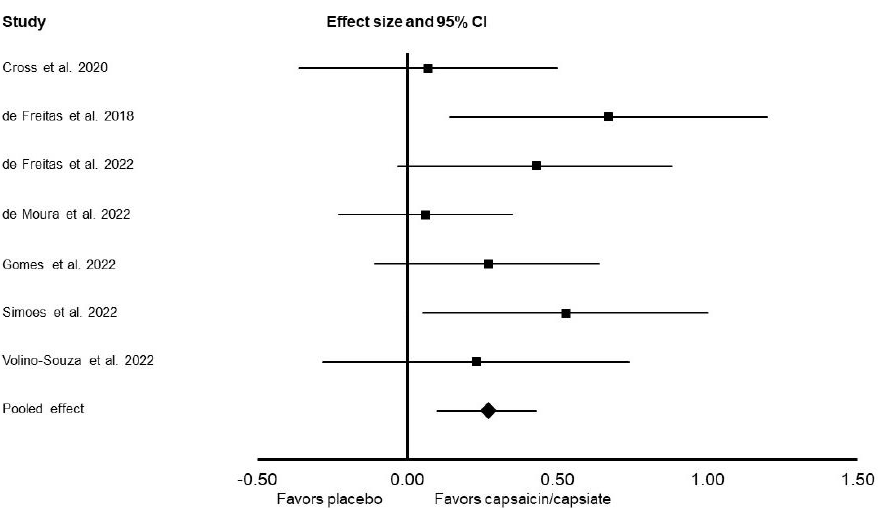
Figure 3. Forest plot presenting the results of the random-effects meta-analysis, which explored the effects of capsaicin/capsiate vs. placebo on muscular endurance. Data are presented as effect sizes (Cohen’s d ) and 95% confidence interval (CI). The diamond at the bottom presents the overall effect. The plotted squares denote effect sizes, and the whiskers denote their 95% CIs. The analysis is based on seven included studies